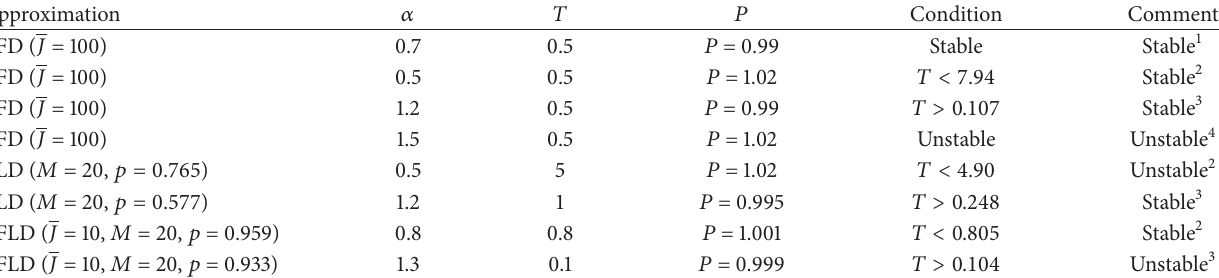
Table 1: Stability results for FFD/FLD/FFLD-based fractional-order Laguerre systems.